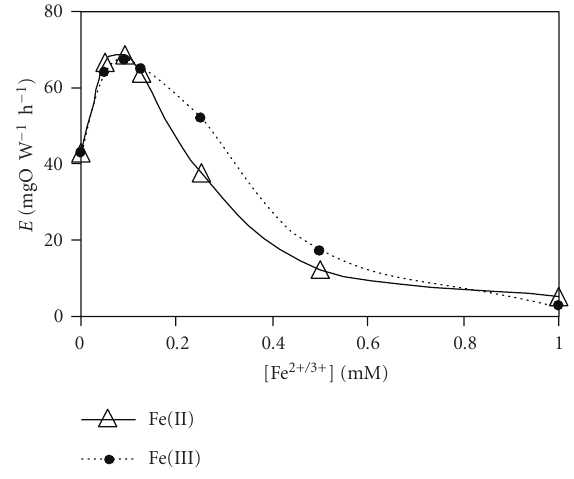
Figure 2: The e ffi ciency of PCO of 2-ethoxyethanol (2-EE) in TiO 2 suspension versus concentration of Fe 2+ ( Δ ) and Fe 3+ ( • ) ions at pH 3.